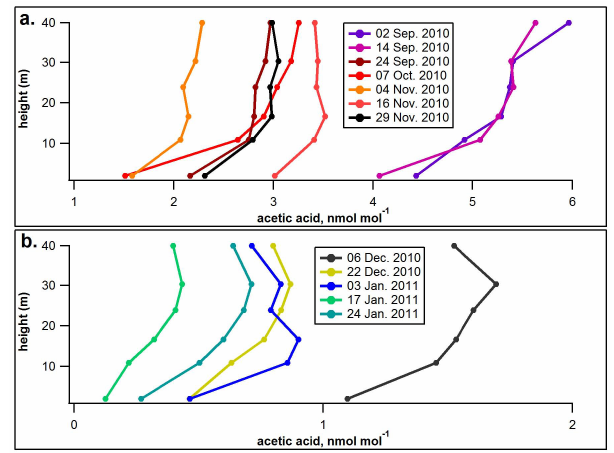
Fig. 3. Weekly averaged vertical concentrations of AA within and above the 30m canopy in the central Amazon (start date shown). (a) 2010 dry season with the highest AA concentrations (1.5– 6.0nmolmol − 1 ) and net deposition. (b) 2010–2011 wet season with low concentrations (0.1–1.7nmolmol − 1 ) and net emissions. The typical standard deviation at each height was about 27% of the mean AA concentration